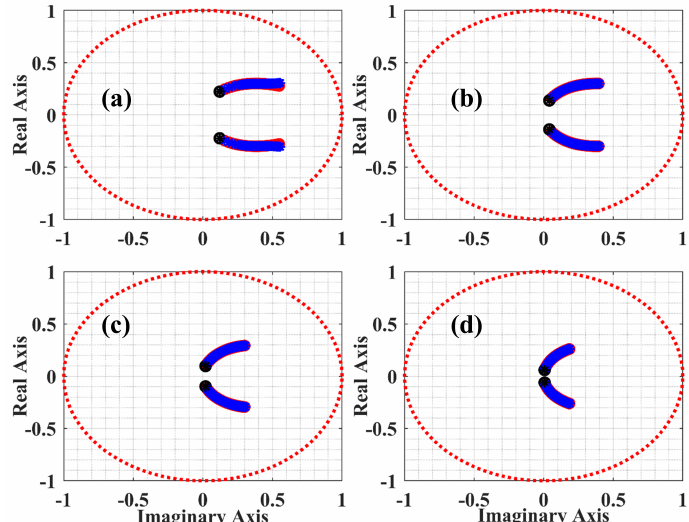
Figure 17. Effect of R on the dynamic response and stability with: ( a ) T s = 2 × 10 − 3 ; ( b ) T s = 4 × 10 − 3 ;